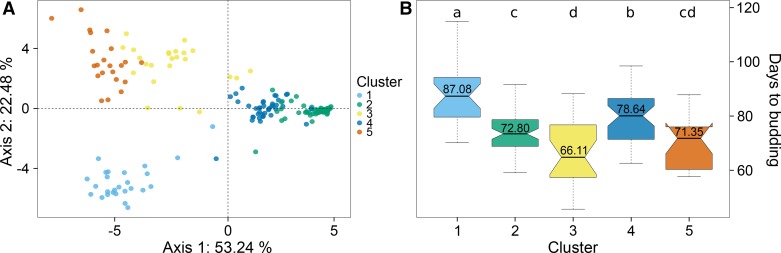
(A) Discriminant analysis of principal components plot for the five inferred clusters using the k-means algorithm (Jombart and Ahmed 2011). (B) Boxplots for number of days to budding for each DAPC-inferred cluster. Letters above boxplots display Tukey-test results. Clusters with the same letter are not significantly differentiated from each other. Values within boxplots display the mean time to budding for each cluster.